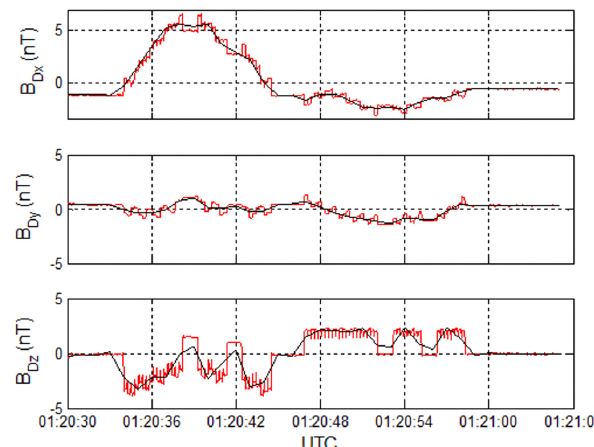
Fig. 6. A comparison of 24h of outboard sensor data from the orbit on 9 June 2006. The data is in the spacecraft co-ordinate system and with offset corrected. Red: data before correction, black: data after correction for SADM, Antenna and Periodic effects. The grey lines mark times when interference from the SADM occurs in the original data.